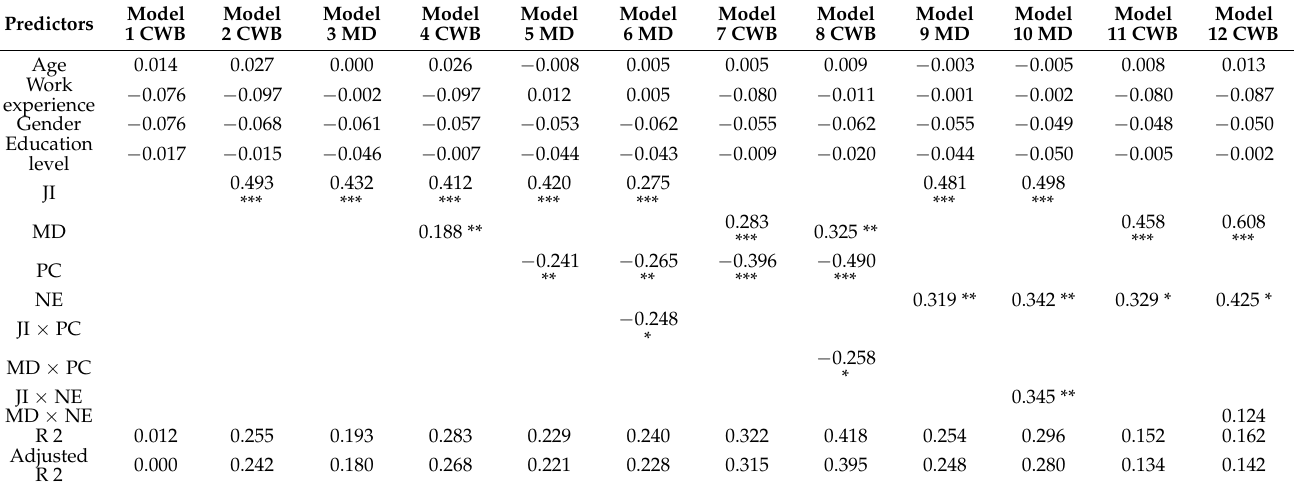
Table 6. Regression analysis for CWB and MD: model